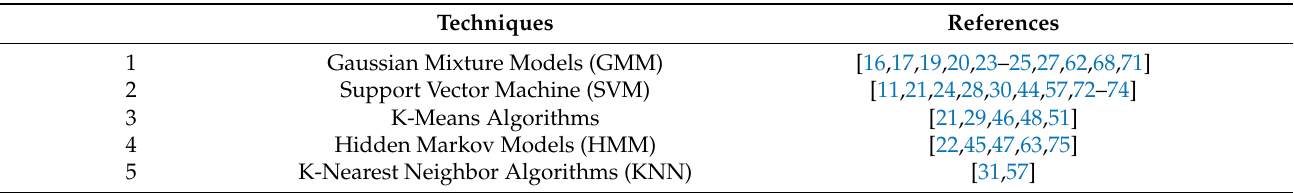
Table 5. Summary of traditional machine learning techniques for sound classification.